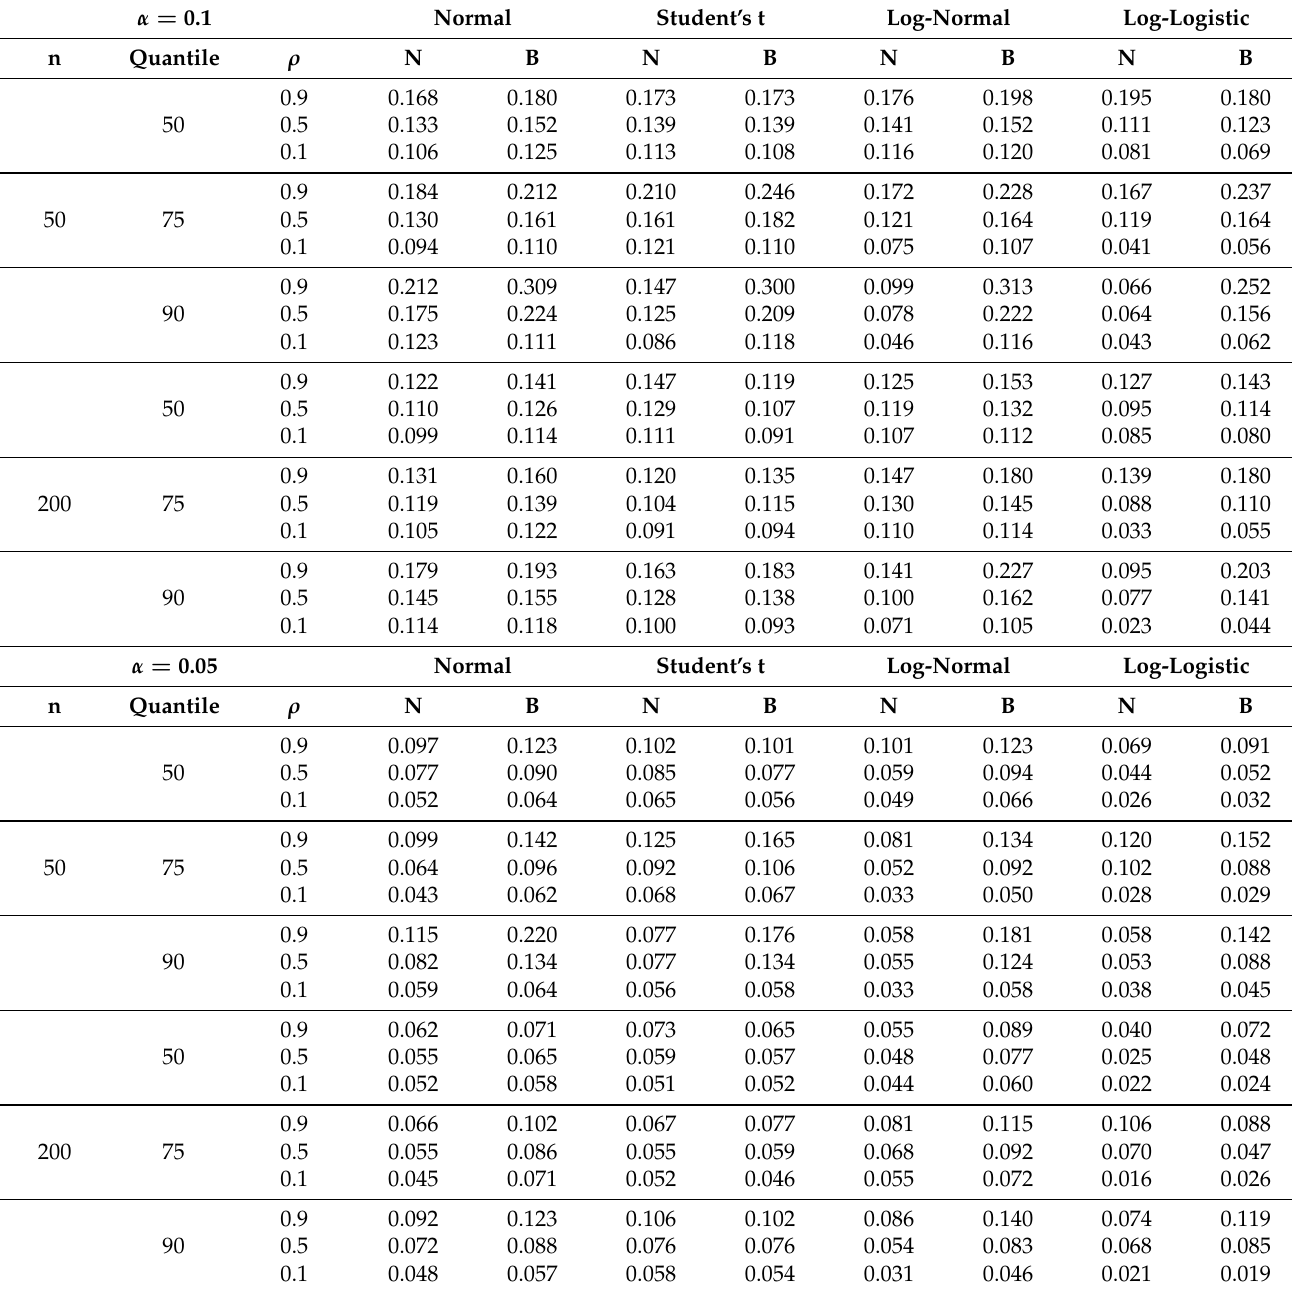
Table 4. Simulation results for local Moran statistic with minimum number of neighbours